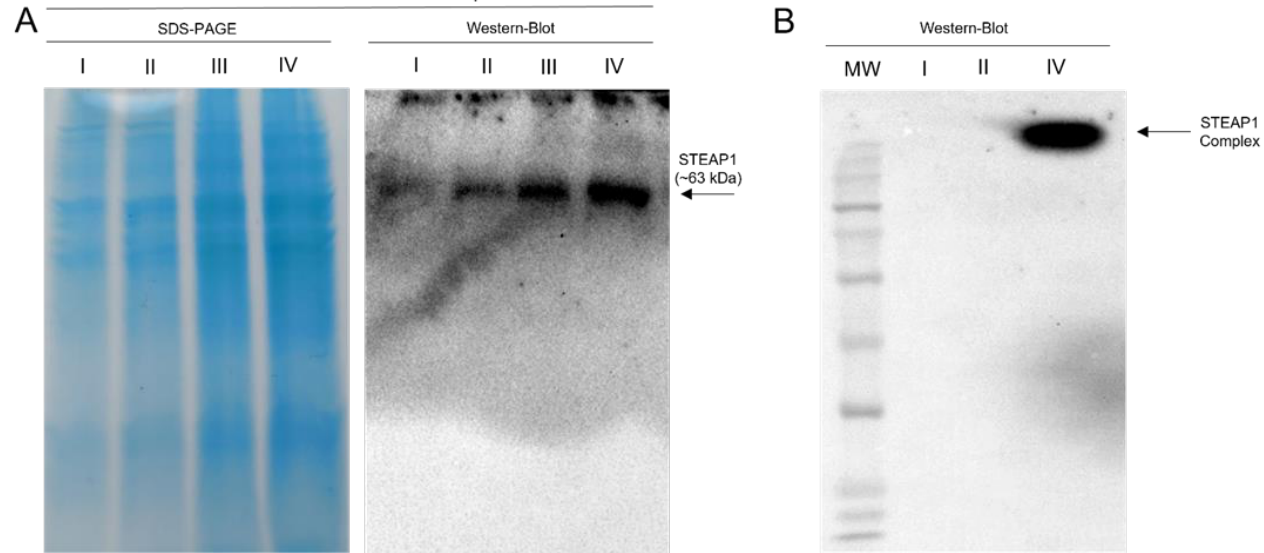
Figure 7. SDS-PAGE and Western blot of the recovered supernatants from the ionic exchange batch for calcium-crosslinked GG microspheres for both a four-step batch ( A ) and condensed batch ( B ) (35 mL GG microspheres); I — sample that did not bind to GG microspheres at 10 mM MES pH 6.2; (35 mL GG microspheres); I—sample that did not bind to GG microspheres at 10 mM MES pH 6.2; II — wash step with 10 mM Tris pH 8 and 100 mM NaCl; III — elution step with 10 mM Tris pH 8 and II—wash step with 10 mM Tris pH 8 and 100 mM NaCl; III—elution step with 10 mM Tris pH 8 and 200 mM NaCl; IV — elution step with 10 mM Tris pH 11 and 500 mM NaCl. 200 mM NaCl; IV—elution step with 10 mM Tris pH 11 and 500 mM